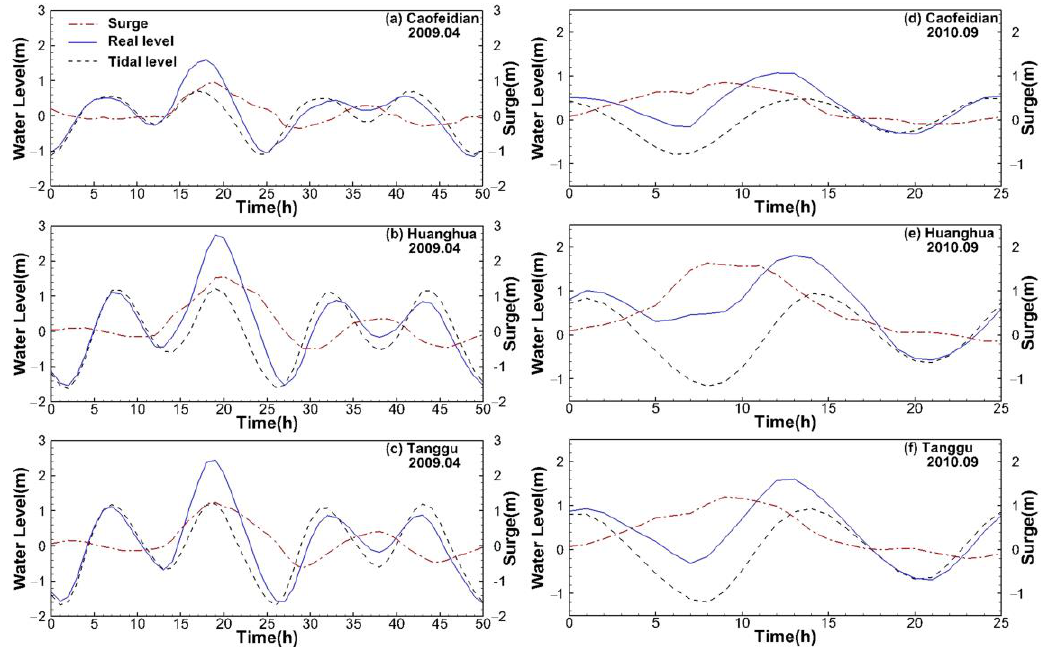
Figure 11. Evolution of surge, tide and total water level during the surge events beginning on 13 April 2009 (panels ( a – c )) and on 21 September 2010 (panels ( d – f )). The total water levels are calculated using run 4, the tidal levels are calculated using run 1 and the surges are calculated as the di ff erence of water levels between run 4 and run 1.